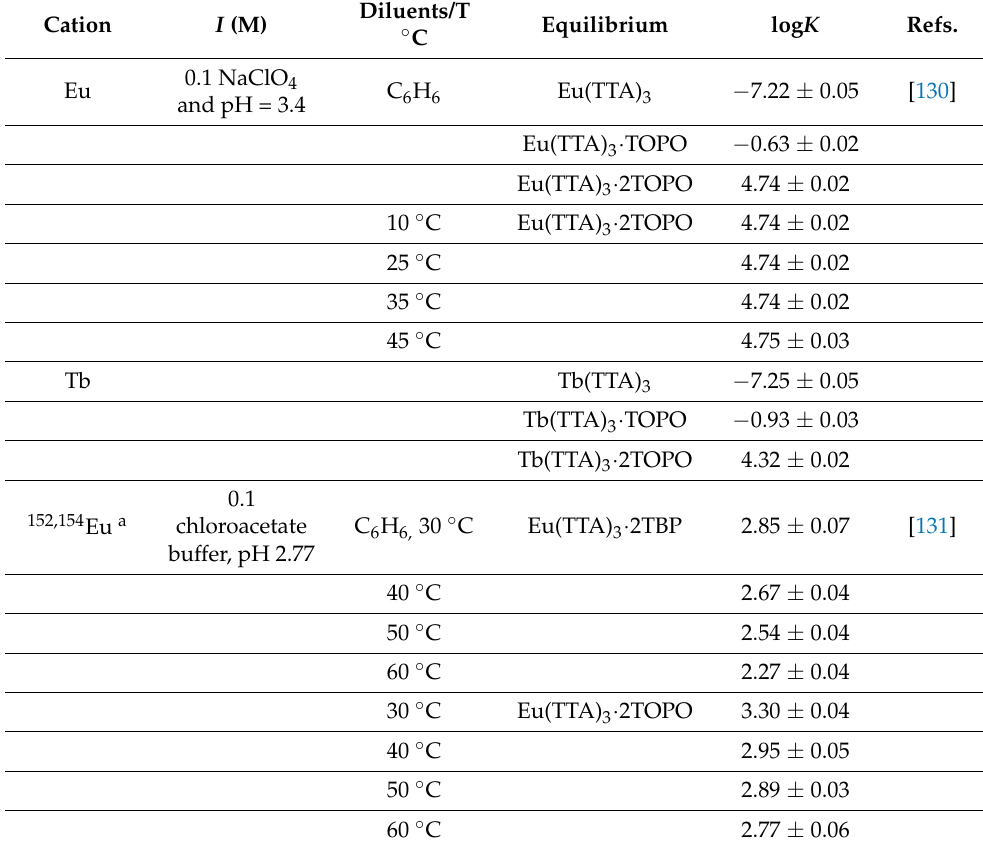
Table 4. Recommended data for the synergistic system of thenoyltrifluoroacetone and organophosphorus ligands when different temperatures were applied.